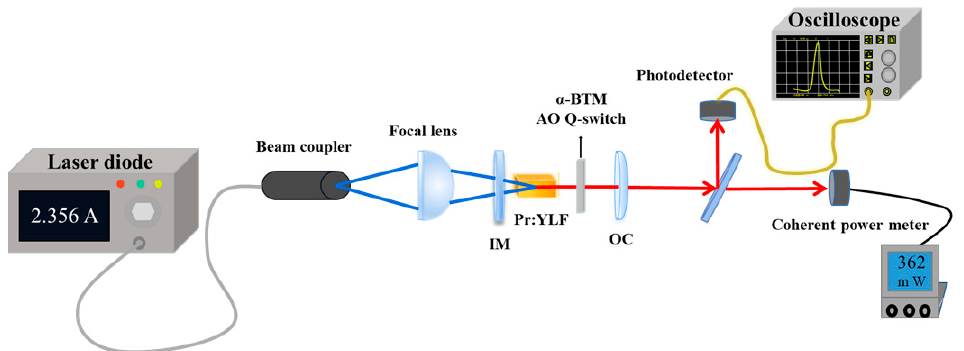
Figure 1. Experimental setups of the α -BTM AO Q-switched Pr:YLF laser.